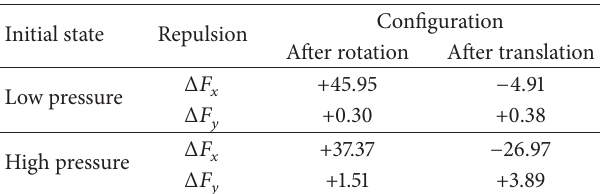
Table 1: Changes in repulsion between clay particles due to the change of